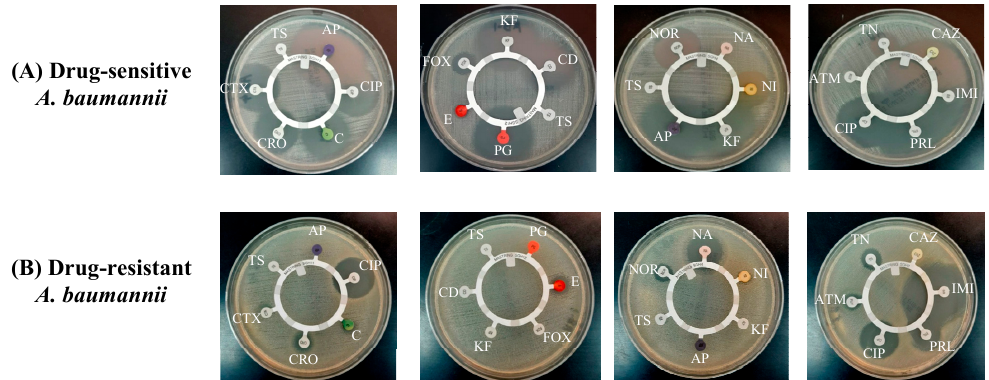
Figure 2. Antibiotic susceptibility screening of ( A ) drug-sensitive and ( B ) drug-resistant A. baumannii .